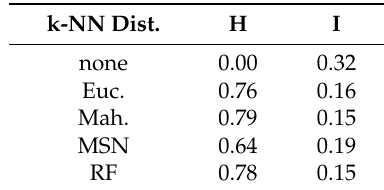
Table 8. Index values (H,I) for k-NN prediction and estimation strategies with k = 3 using the three predictor variables P30, P90, and Cover(1.50) and responses TPH and Vol. for all species combined. We also include the baseline variability (k-NN dist = none) describing plot variability around population dbh density. k-NN Dist. H I none 0.00 0.32